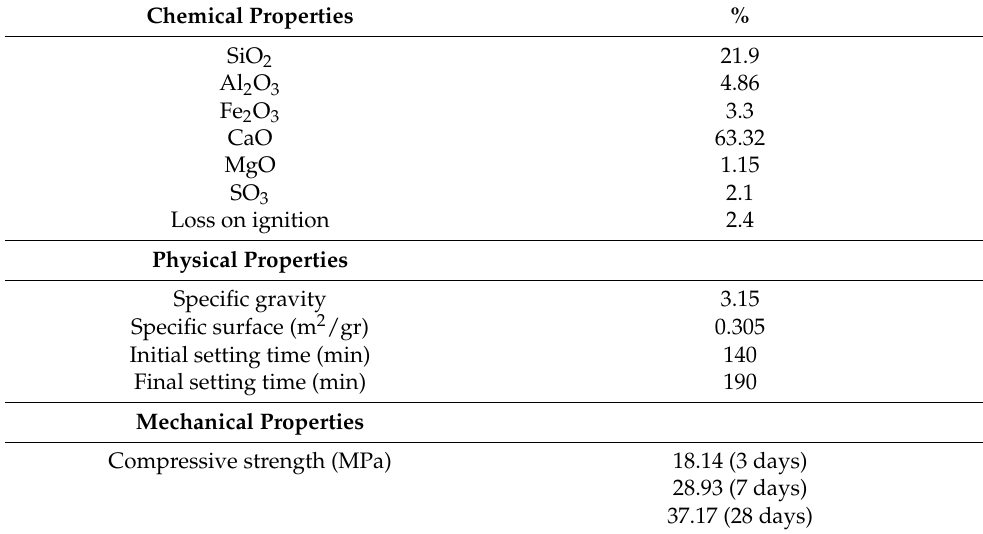
Table 3. Properties of